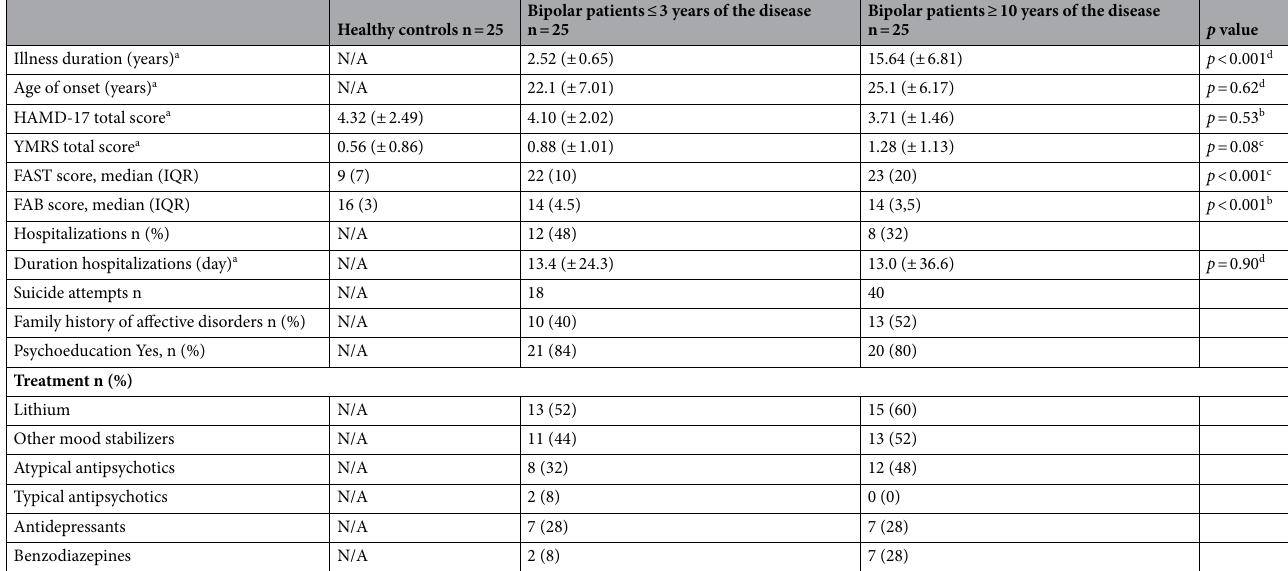
Table 2. Clinical and pharmacological characteristics of the sample. HAMD-17 = Hamilton Depression Rating Scale; YMRS = Young Mania Rating Scale; FAST = Functioning Assessment Short Test; FAB = Frontal Assessment. Battery; N/A = not available; IQR = interquartile range a Mean (±SD) b t test c Mann-Whitney.